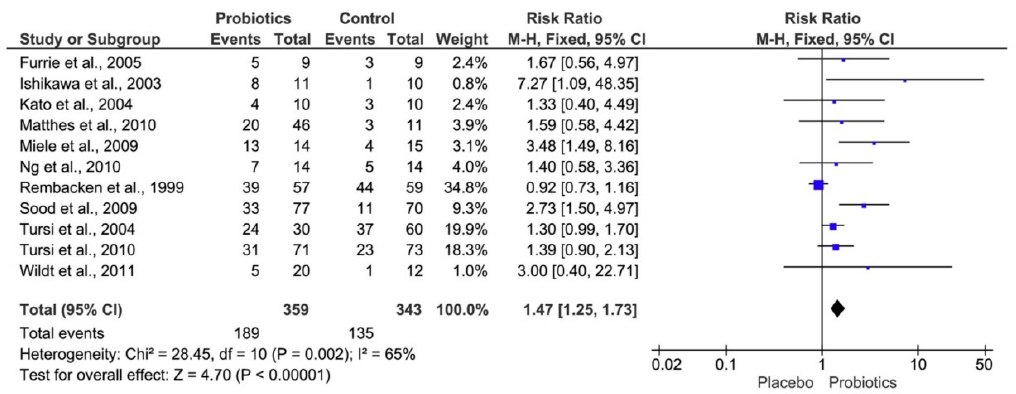
Figure 8. Forest plot showing the effect of probiotics on inflammatory bowel diseases (IBD) [21].